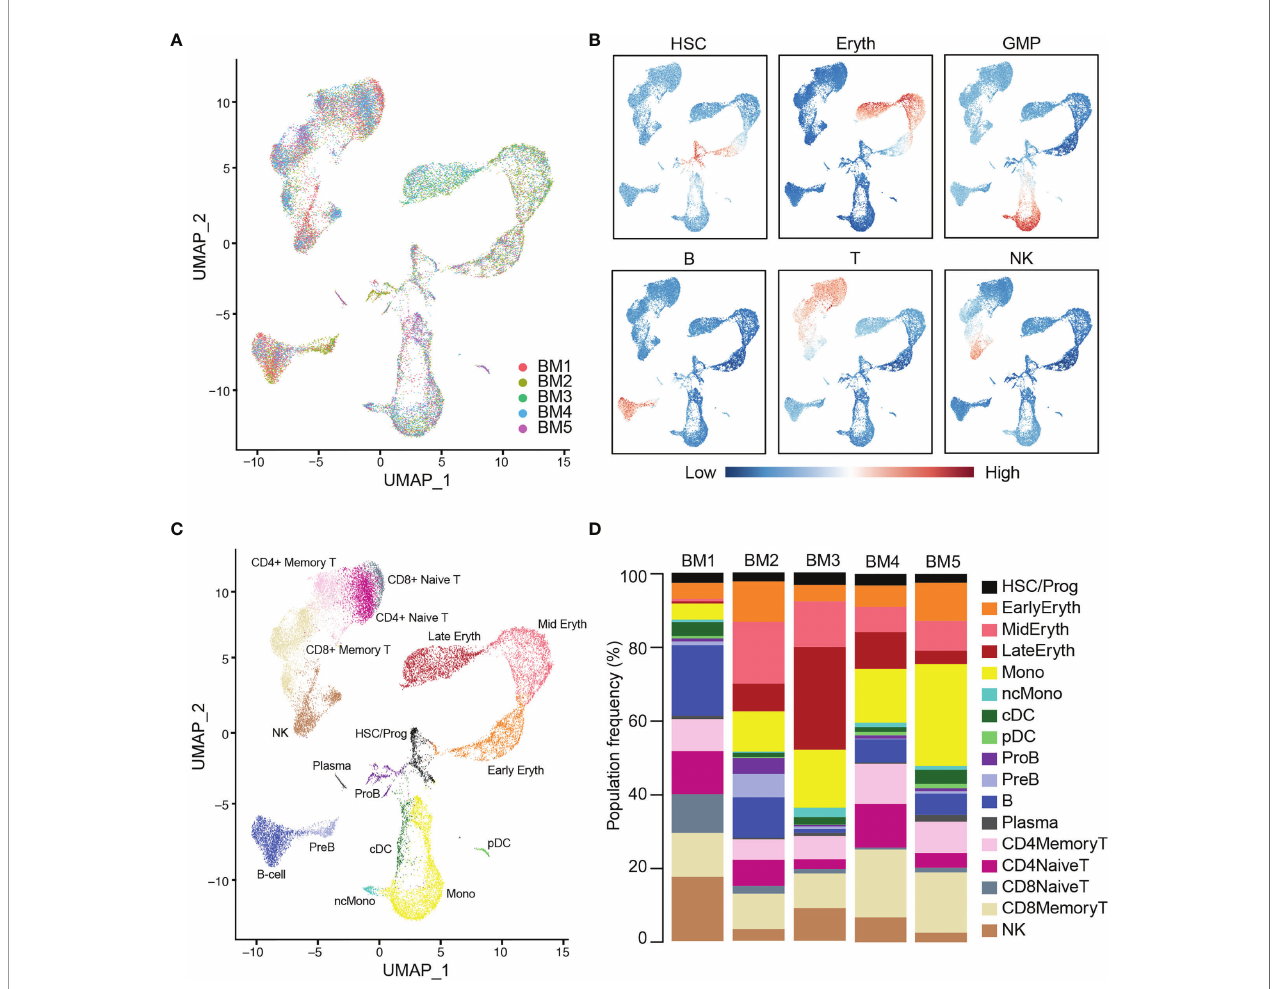
FIGURE 1 | Integration and labeling of fi ve healthy bone marrow control samples. (A) UMAP visualization of Seurat-integrated scRNA-seq data for 25,726 hematopoietic cells from fi ve normal BM aspirates. (B) Expression scores for lineage signatures overlaid on the UMAP of healthy BM in (A) . (C) UMAP shows 17 clusters of cells with similar transcriptional states, identi fi ed by Seurat clustering and sub-clustering of healthy BM. (D) Stacked barplots show the frequencies of cell types in fi ve normal BMs. Bone marrow (BM), hematopoietic stem cells (HSC), erythroid cells (Eryth), granulocyte-macrophage progenitor (GMP), B-cells (B), T-cells (T), natural killer cells (NK), progenitor (Prog), monocyte (Mono), non-classical monocyte (ncMono), conventional dendritic cells (cDC), plasmacytoid dendritic cells (pDC), pro-B cells (ProB), pre-B